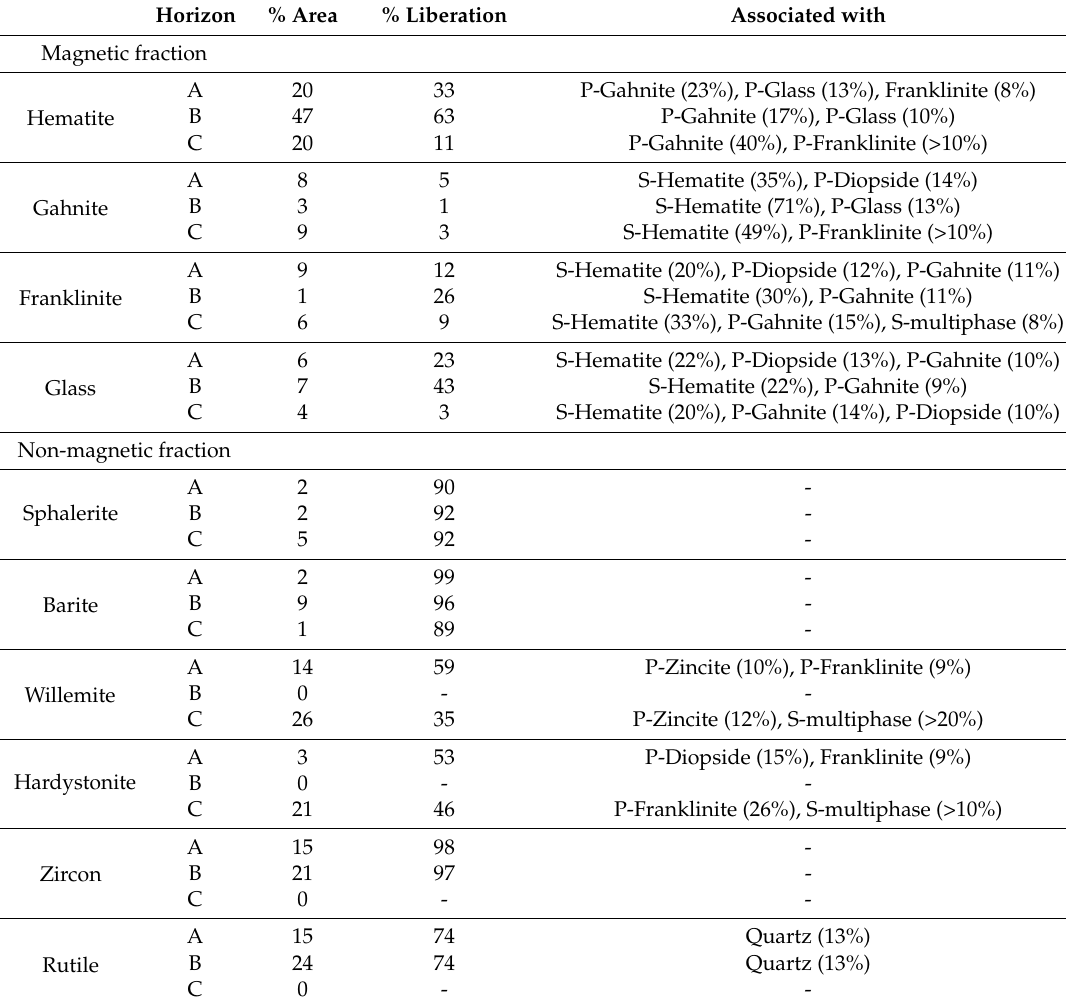
Table 1. Mineral Liberation Data for major phases from magnetic and non-magnetic fractions, “% Area” is proportion of the phase in the bulk samples of either magnetic or non-magnetic fraction, “% Liberation” is the characteristic for each phase showing how much of the phase is fully liberated (i.e., not associated with other minerals), “Associated with” is the characteristic of each phase, which is not fully liberated and occurs with other phases in a single